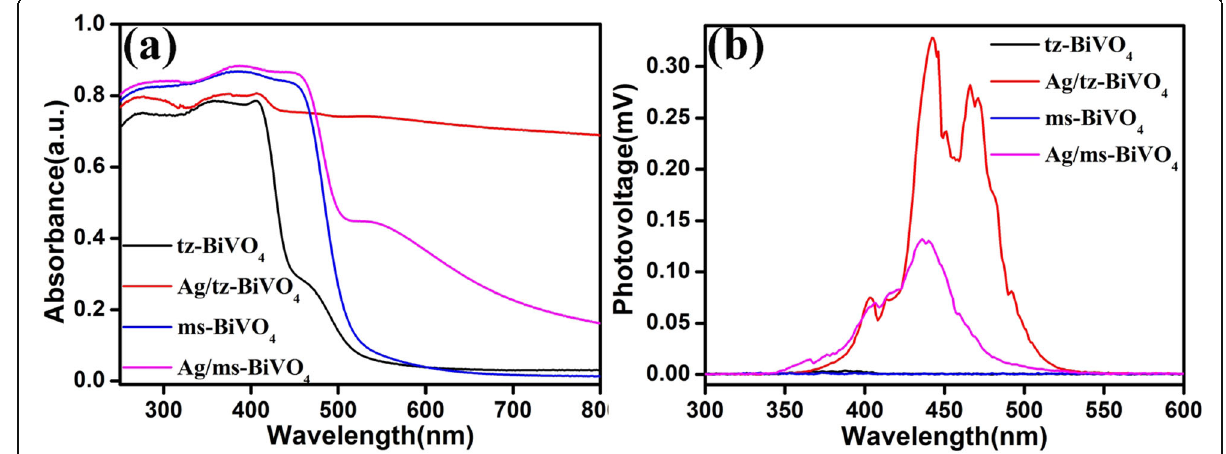
Fig. 3 UV-visible diffuse reflectance spectra ( a ) and surface photovoltage spectra ( b ) of the as-prepared